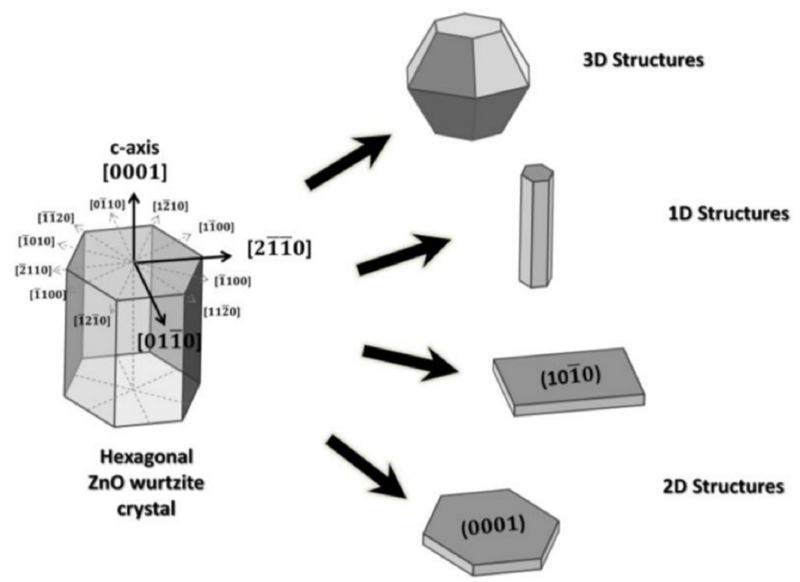
Figure 2. Preferential growth directions of ZnO wurtzite crystal and possible structures. Reproduced with permission from [14].